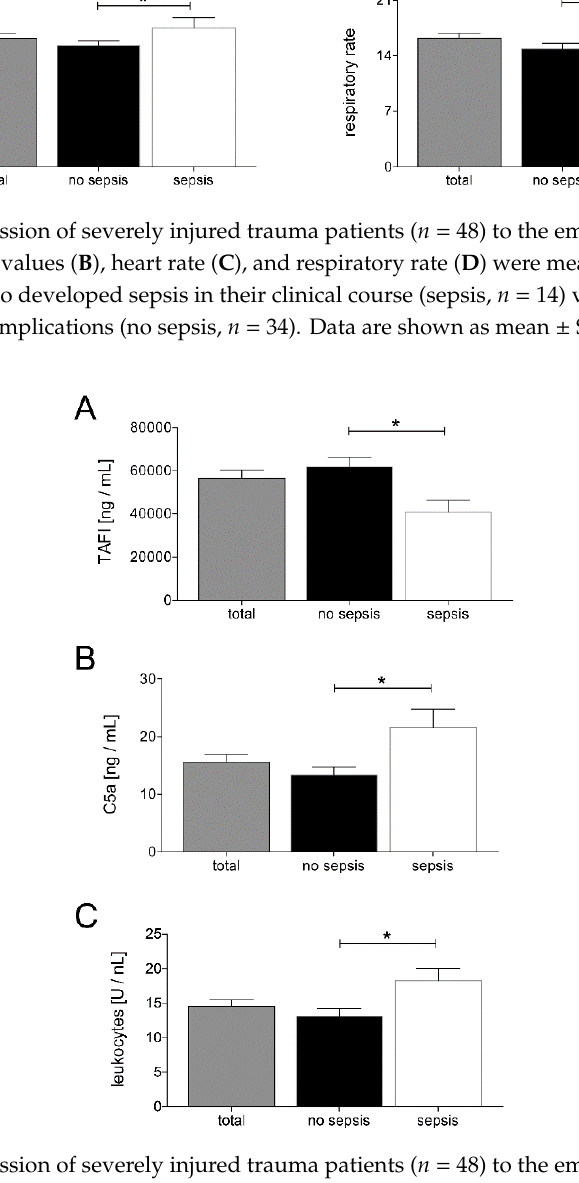
Figure 2. Upon admission of severely injured trauma patients ( n = 48) to the emergency department, plasma thrombin-activatable fibrinolysis inhibitor (TAFI) levels ( A ), plasma C5a levels ( B ), and leukocyte counts ( C ) were determined. Patients were stratified to those who developed sepsis in their